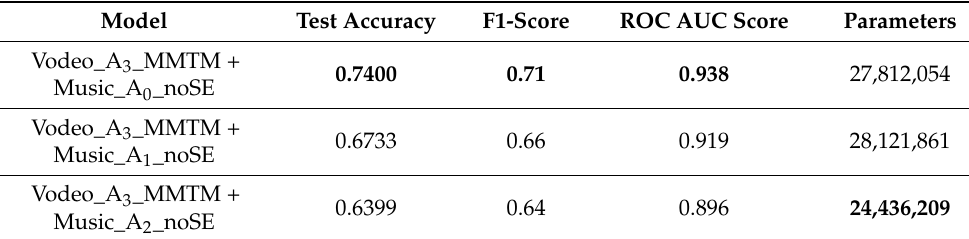
Table 5. Test results using music and video